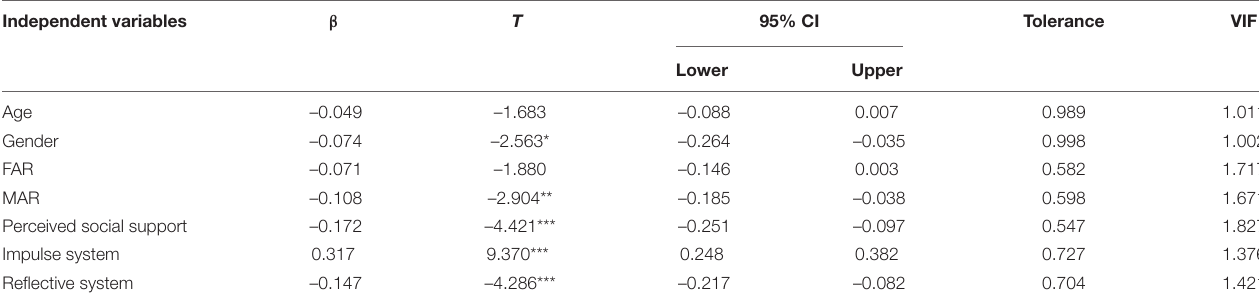
TABLE 2 | Multiple linear regression analysis ( N = 732).